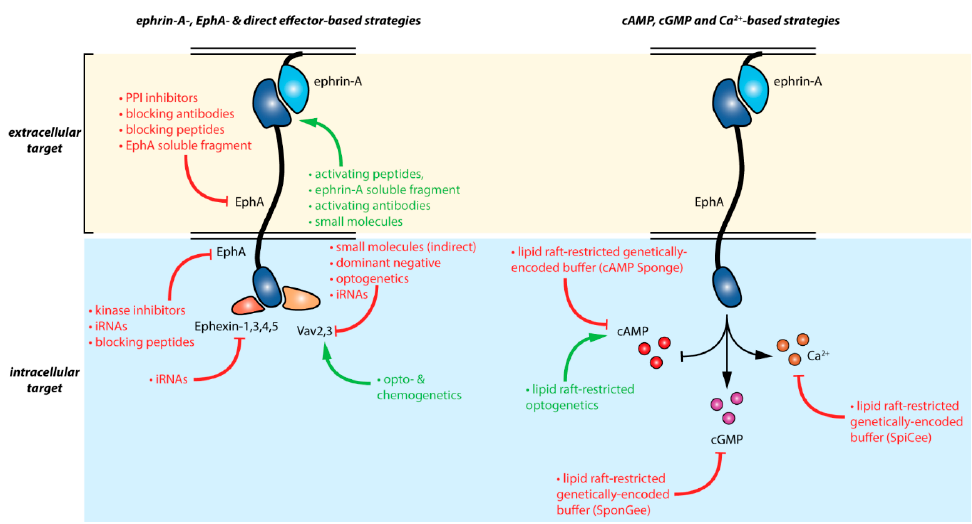
Figure 2. Summary of the available strategies enabling the manipulation of ephrin-A:EphA signaling. Red and green arrows indicate inhibitor and activator effects respectively. Details are provided in Table 1.